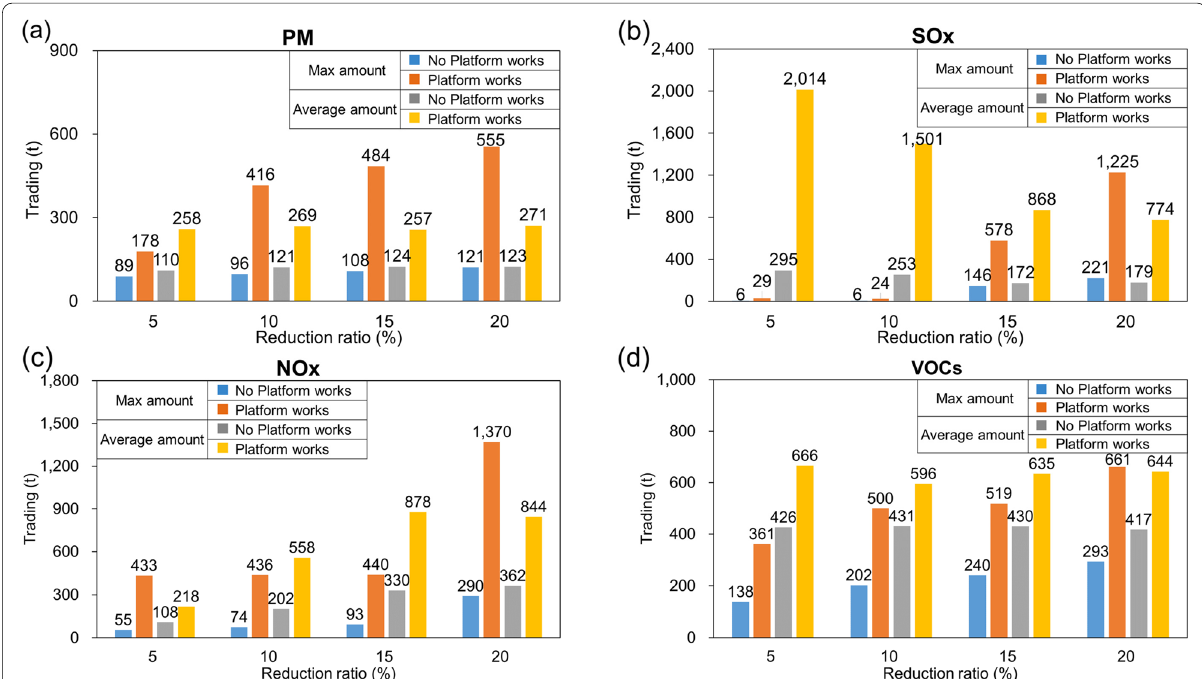
Fig. 3 Comparison diagram of trading amounts of ( a ) particulate matter (PM), ( b ) SO x , ( c ) NO x , and ( d ) volatile organic compounds (VOCs) under different reduction ratios. Note: trading ratio (trading amount/reduction =